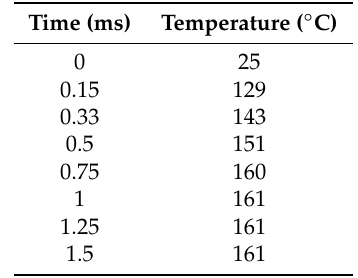
Table 1. Experimental data for steel temperature at the centre of tin drop [58].